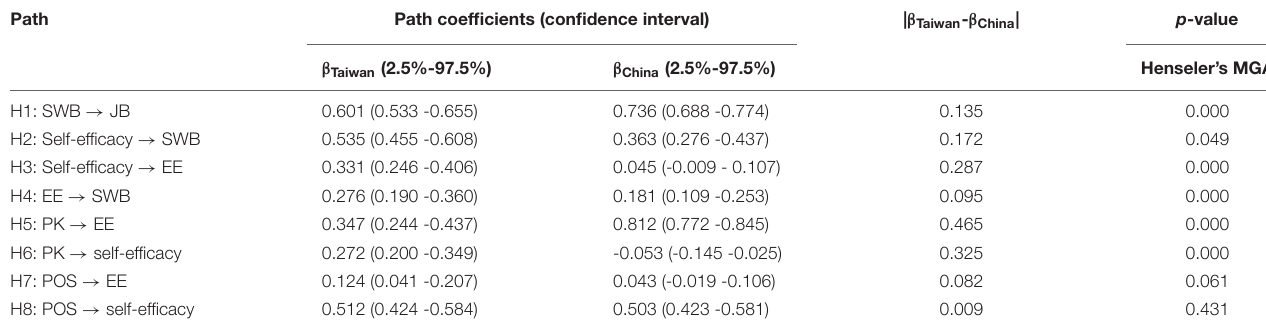
TABLE 2 | Multi-group analysis